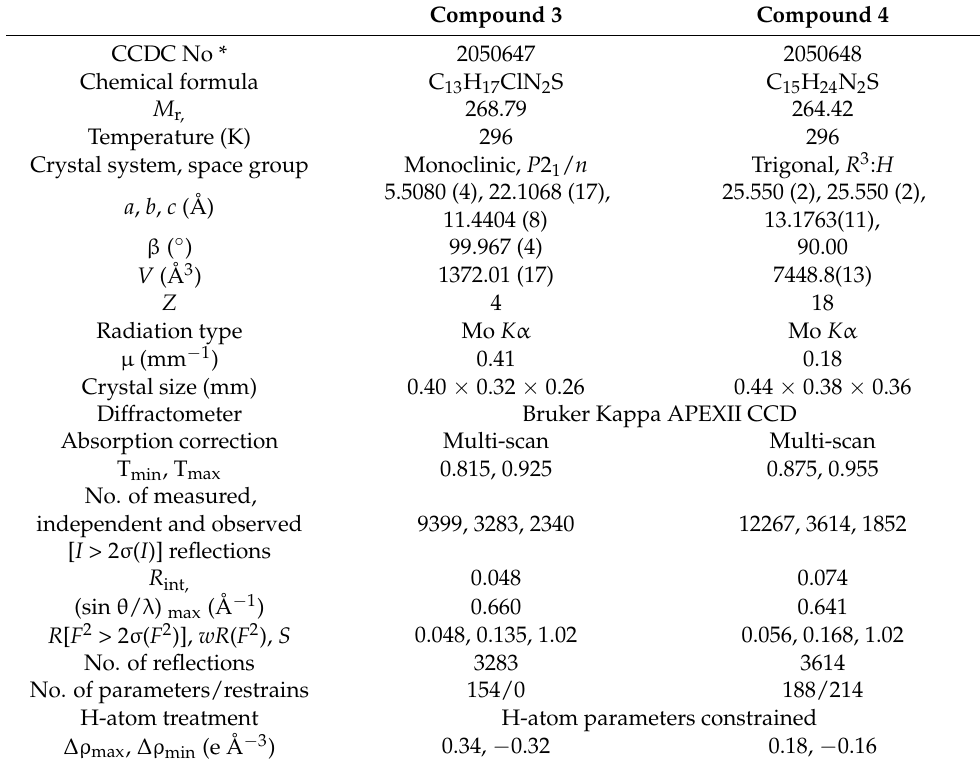
Figure 2. X-ray structure of Compound 3 ( left ), ellipsoids are drawn at 50% probability level, H atoms are omitted, selected carbon atoms and all non-carbon atoms are numbered. Dimer of compound 3 ( right ) stabilized through N1H–S1 interactions. Other secondary interactions in molecules were not detected. For data related to structural determination and refinements and selected structural parameters (bond lengths and angles) see Tables 1 and 2, respectively. Table 1. Structure solution and refinements parameters of compound 3 and 4.